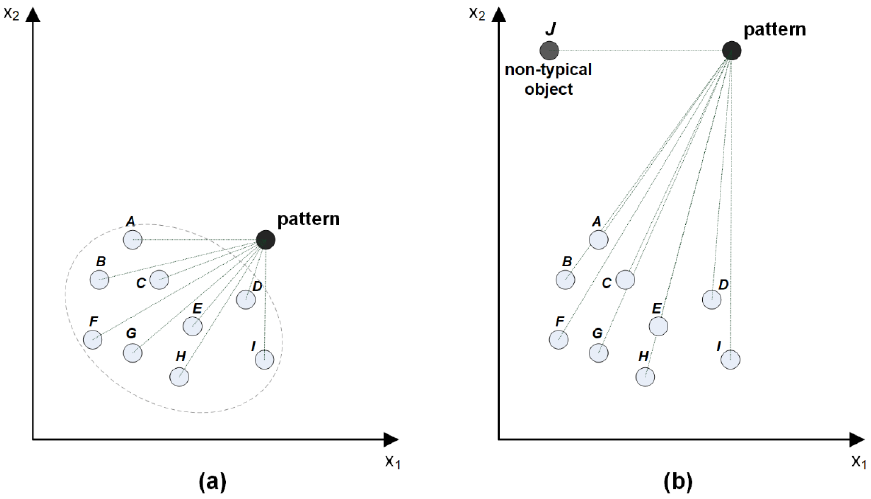
Figure 1. Effect of object location on the pattern: ( a ) without a non-typical object; ( b ) with an additional non-typical object. After changing the position of an object with respect to the coordinates, its place in